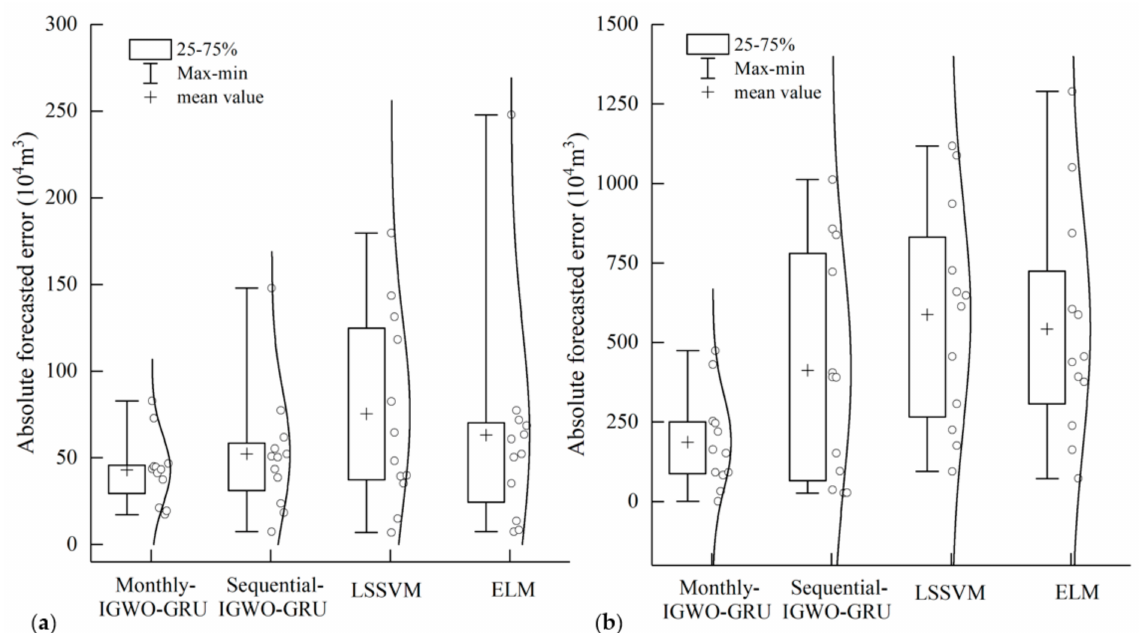
Figure 9. Boxplots of absolute error (AE) of models between forecasted and original streamflow for the Shangjingyou station ( a ) and the Fenhe reservoir station ( b